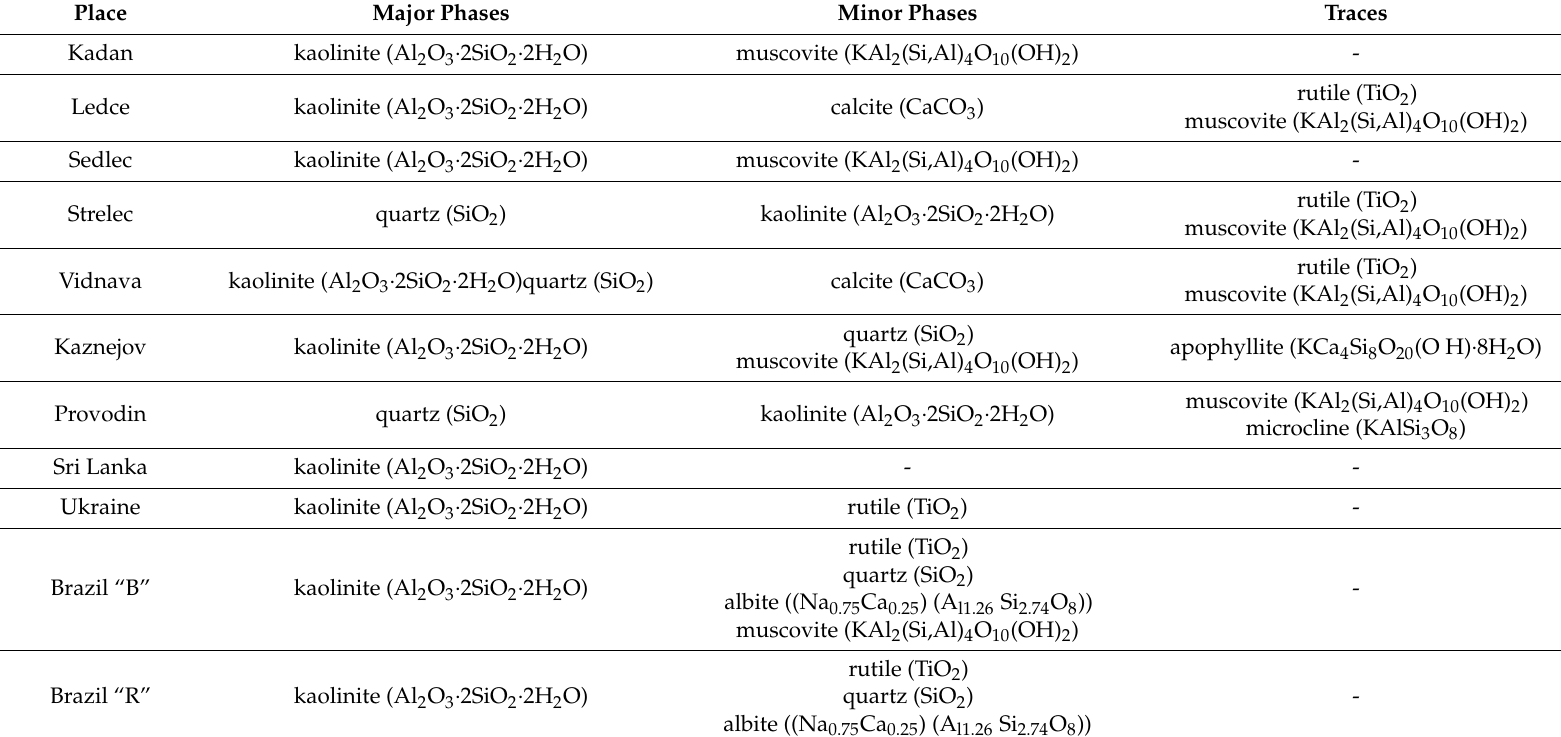
Table 3. The Mineralogy of the Types of Clay Studied (Based on XRD